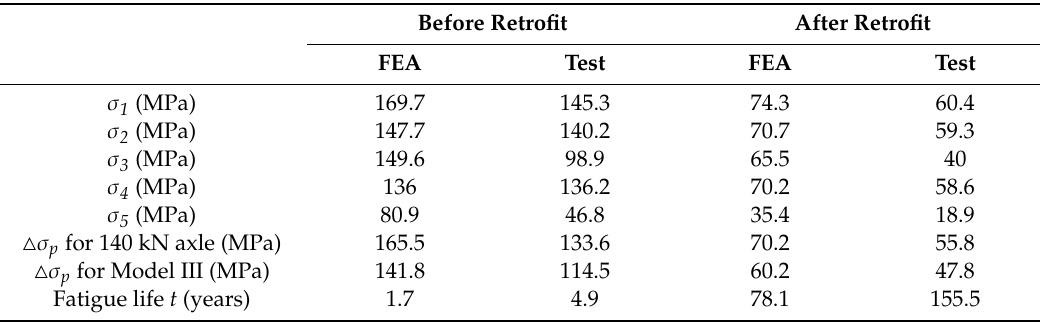
Table 2. Fatigue Life